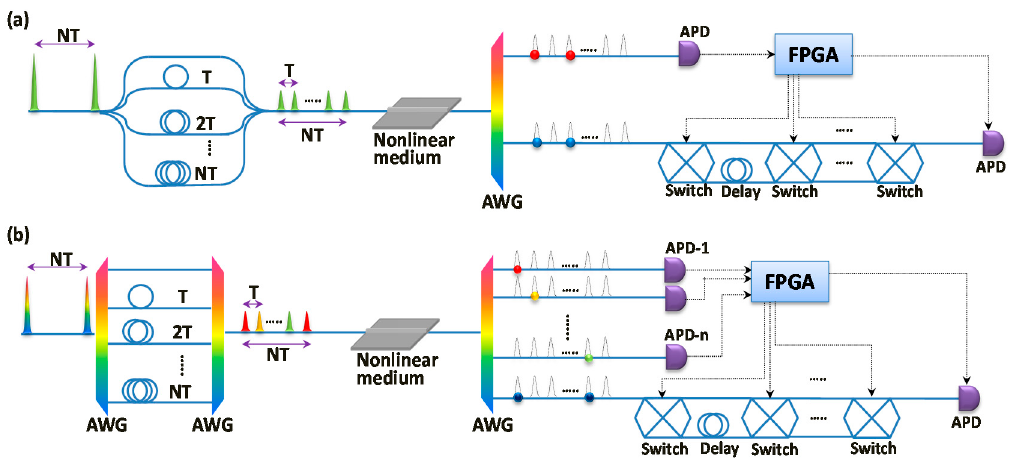
Figure 1. ( a ) Schematic of active temporal multiplexing. The light green pulses are pump pulses with narrow spectrum. The red ball represents a heralding photon, the dark blue one is the corresponding heralded photon. A field-programmable gate array (FPGA) controls delay routes of each heralded photon. APD: avalanche photon detector. ( b ) Schematic of active temporal and wavelength multiplexing. Colorful pump pulses indicate the wide spectrum. Red, yellow, and light green balls indicate heralding photons at different wavelengths. The dark blue ball represents a heralded photon. Blue lines represent optical fiber connections and black dashed lines denote electronic connection. The pulses after arrayed waveguide grating (AWG) indicate their timing